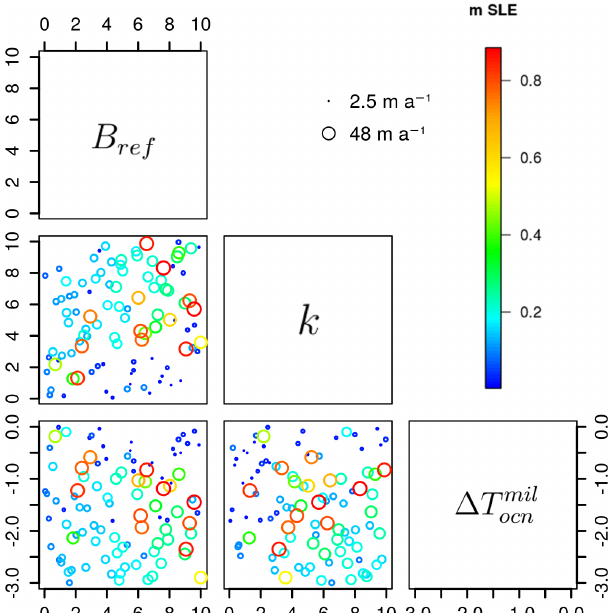
Figure 3. Evaluation of the effect of the oceanic millennial-scale variability for each pair of parameters perturbed in the basal melt- ing equation (Eq. 6). The ranges of ε V (m SLE, colour scale) from Eq. (7) and ε U (ma − 1 , circle size) from Eq. (8) are shown. The sim- ulation with the highest millennial-scale variability is represented by the largest red circle; the simulation with the lowest variability is represented by the smallest blue